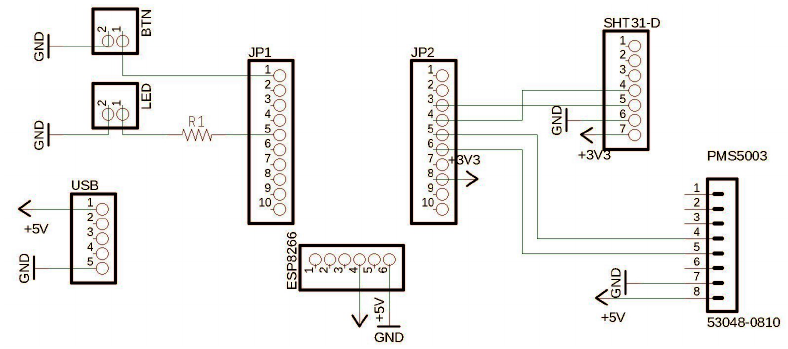
Figure 4. Dustbox 2.0 schematics.